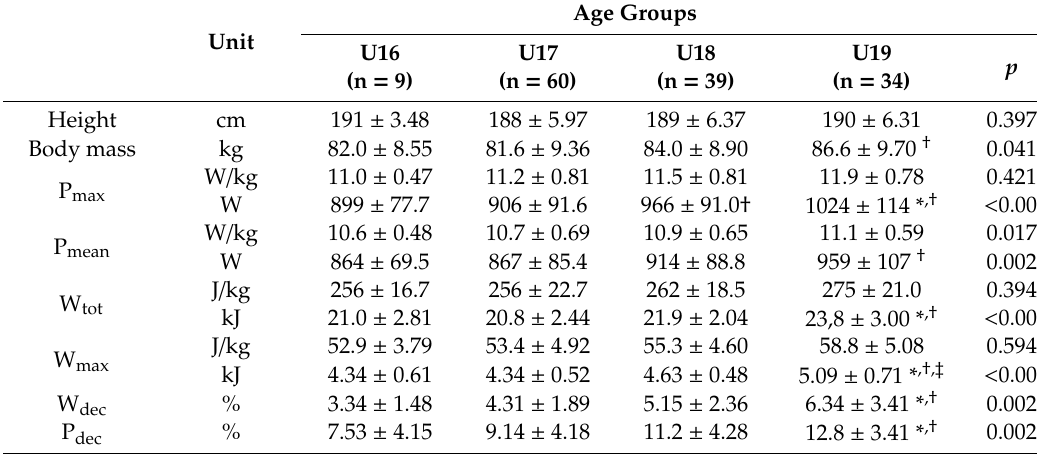
Table 1. Repeated sprint ability (RSA) test results with regard to age groups.